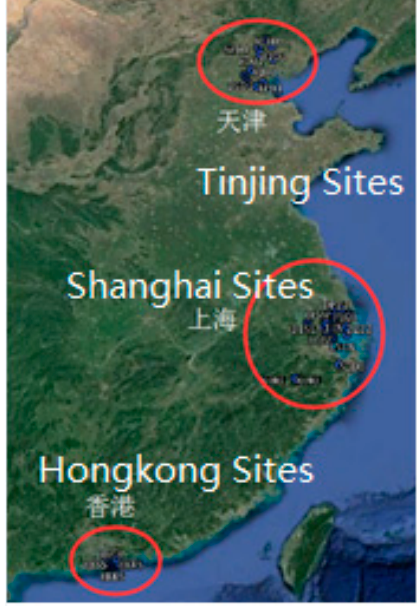
Figure 1. Regional Station Distribution Diagram.